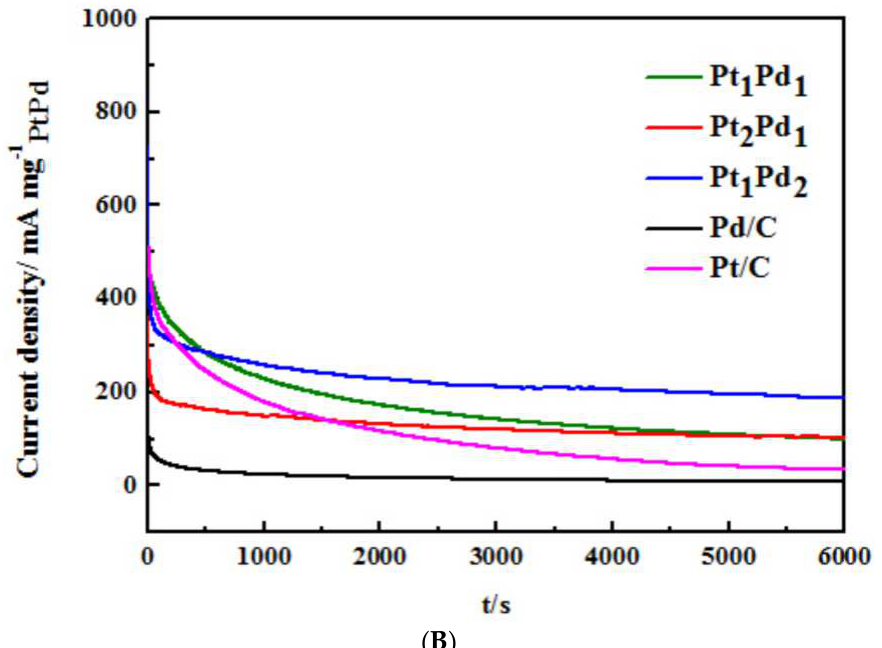
Figure 4. ( A ) CV, ( B ) i–t curves of Pt 2 Pd 1 NCs/MWCNTs, Pt 1 Pd 1 NCs/MWCNTs, Pt 1 Pd 2 NCs/MWCNTs and the commercial Pd/C catalysts in a solution containing 0.5 M KOH +2.0 M CH 3 OH. Table 2. The compared electrochemical performance of PtPd NCs/MWCNTs with the other reported Pd-based catalysts for methanol oxidation.